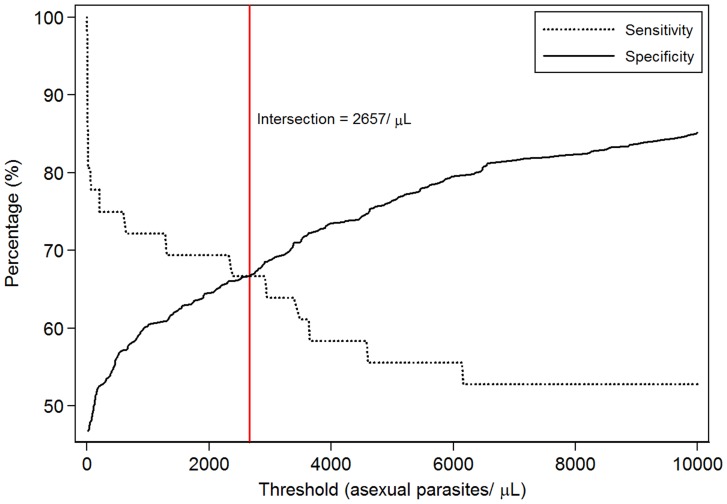
Malaria case definition using objective fever (Temperature≥38.0): Sensitivity and specificity of alternatives parasite threshold.